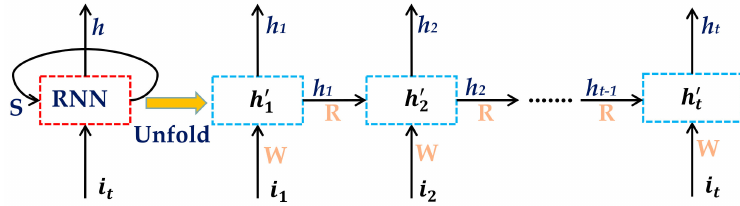
Figure 3. A simple unfold recurrent neural network (RNN)